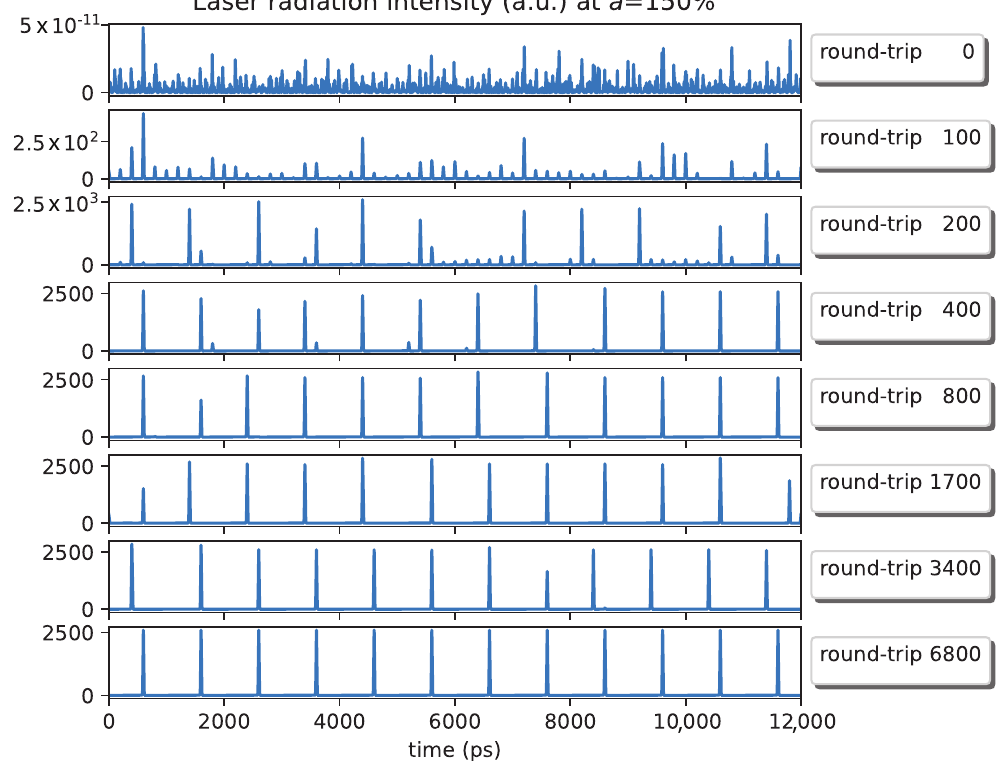
Figure 7. Laser radiation temporal fine structure calculated numerically at modulation depth a = 150%. T d = 11,330 ps. Other simulation parameters are given in Table